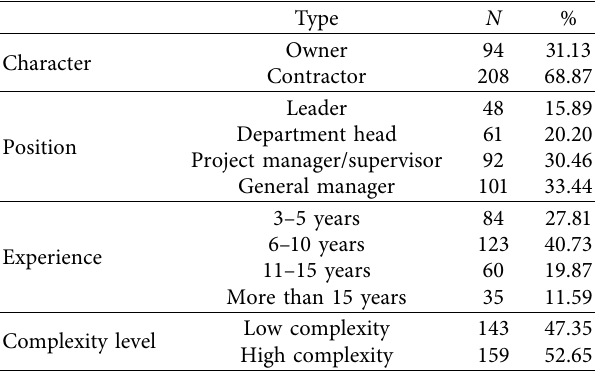
Table 1: Sample background